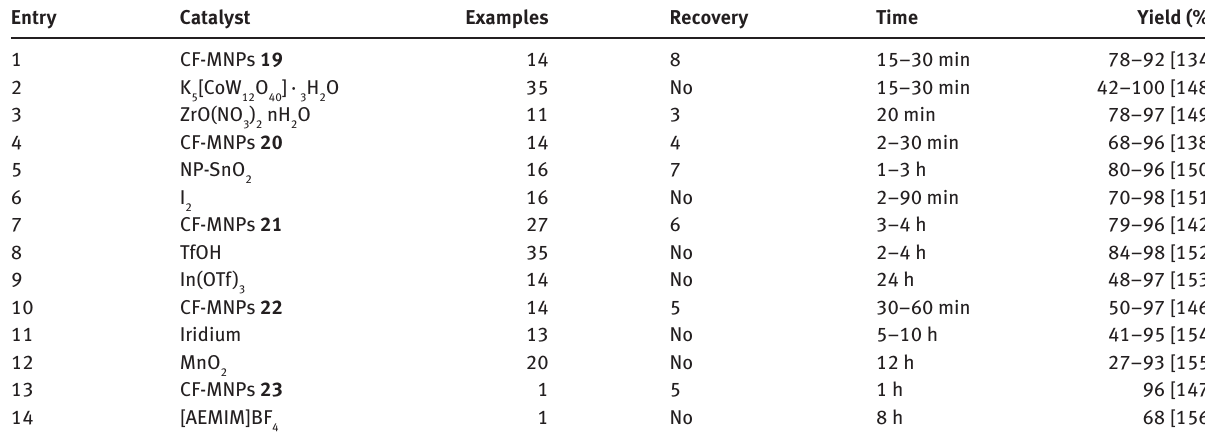
Table 9: Comparison of the activity of CF-MNPs catalysts with other reported catalysts in the alcoholysis of epoxides (entries 1–3), Knoev- enagel condensation (entries 4–6), Ritter reaction (entries 7–9), N -formylation (entries 10–12), and synthesis of 5-hydroxymethylfurfural (entries